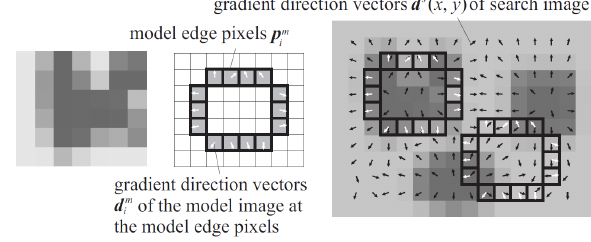
Figure 4: Principle of shape-based matching: Model image, model edges and search image according to (Ulrich,